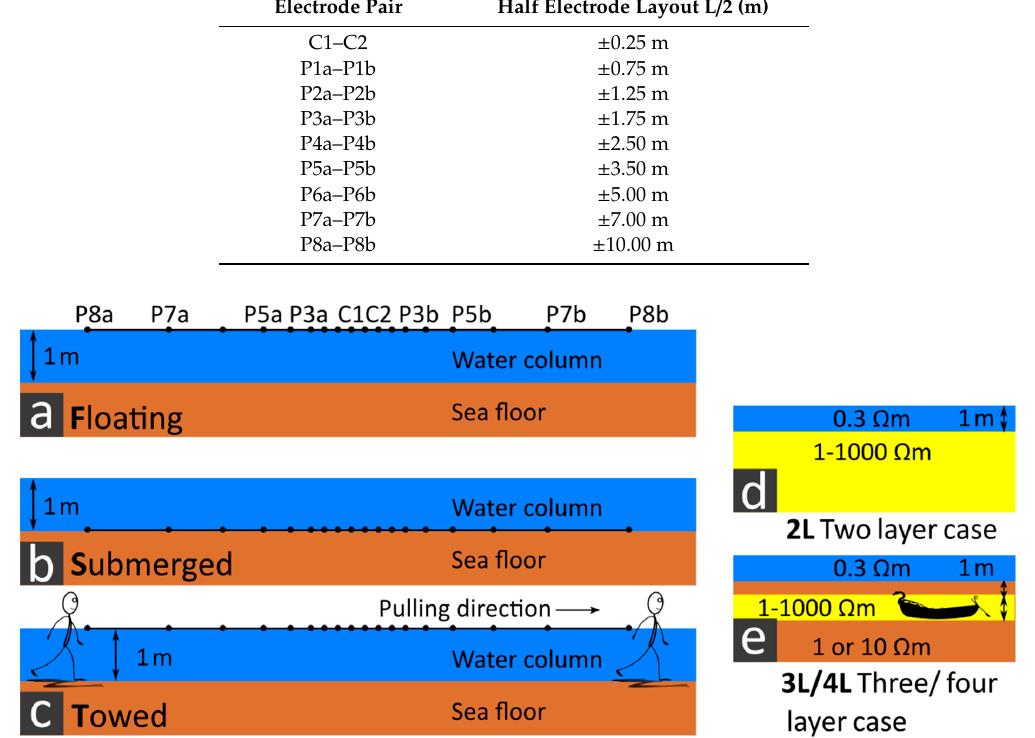
Figure 1. Left column: Schematic view of different measurement setups including ( a ) stationary floating electrodes (setup F), ( b ) stationary submerged electrodes (setup S) and ( c ) towed floating electrodes (setup T). Right column: Images of ( d ) two-layer (2L), and ( e ) three-layer cases (3L), approximating meter-scale targets. “C” indicates the current electrodes and “P” the potential electrodes of the streamer.